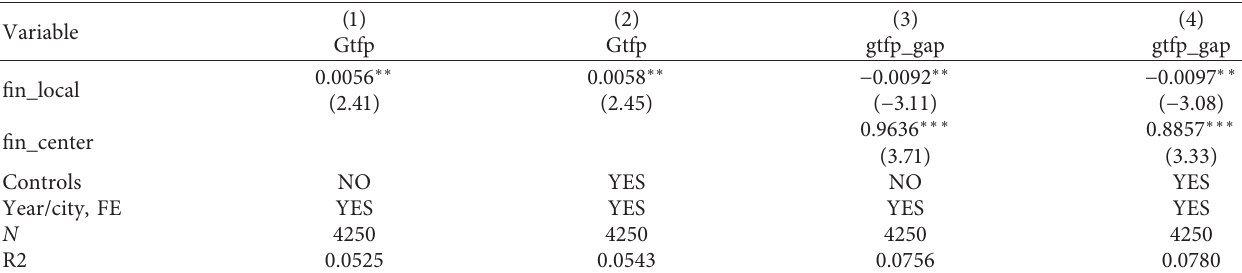
Table 3: Baseline regression.